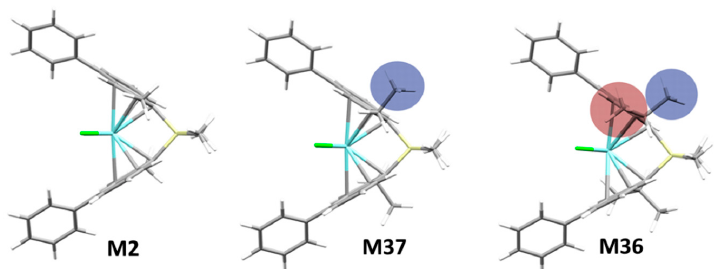
Figure 2. Increasing the steric demand of substituents at the 2-position negatively affects stereoselectivity if they intrude into the active pocket (see e.g., M37 vs. M36 ). Stereoselectivity ( σ ): M2 (2-Me) 0.9988 ≈ M37 (2-Et) 0.9989 > M36 (2- i Pr) 0.9720.